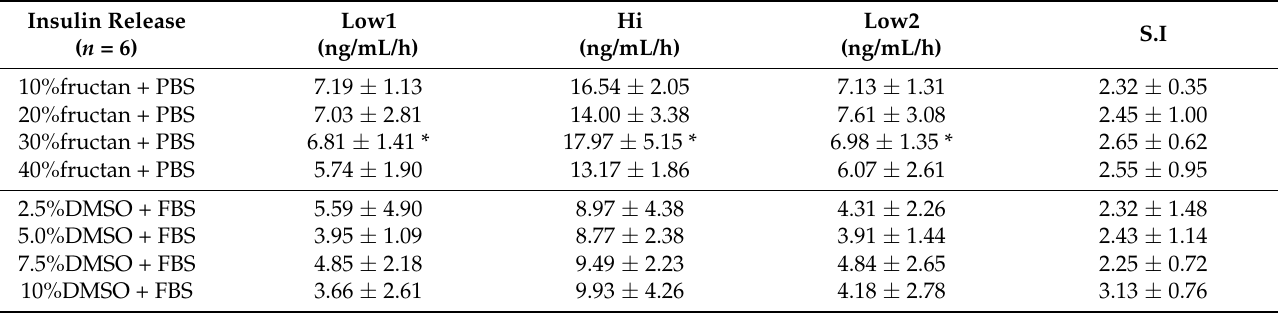
Table 1. Insulin release